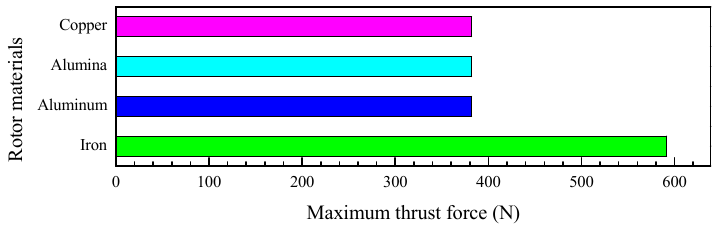
Figure 9. Comparisons of the maximum thrust force when the rotor is made from different materials. Threads are the helical structure installed or fabricated on the cylindrical surface of the translator.